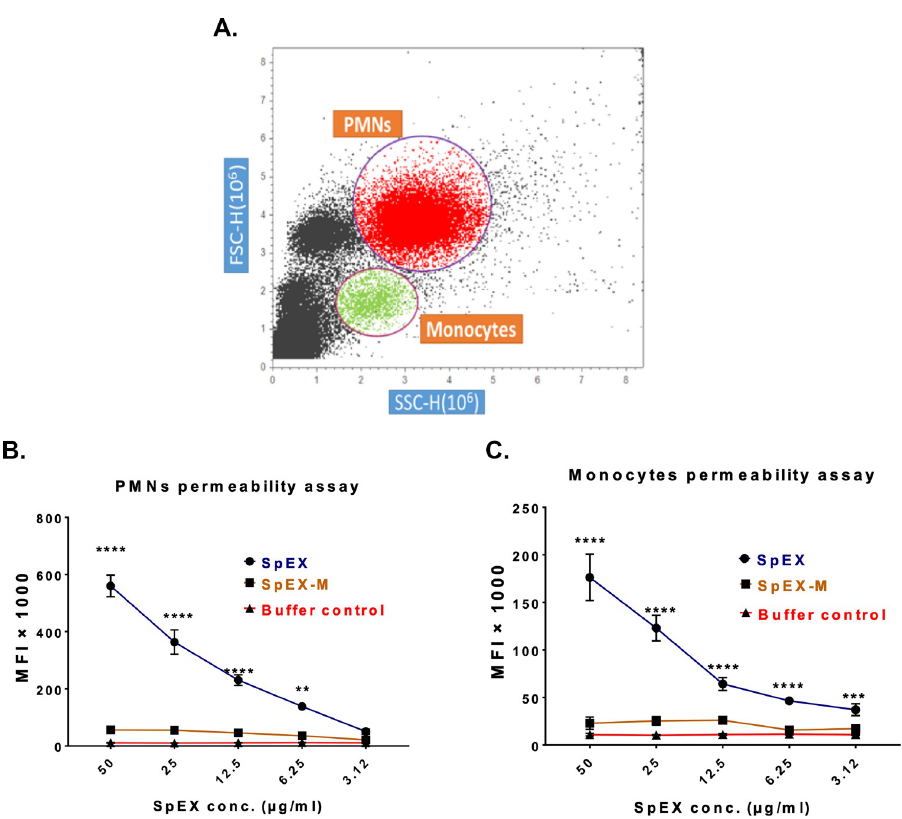
Fig 8. S . pseudintermedius recombinant SpEX has a cytotoxic effect on canine monocytes and PMNs. a . Gating on canine monocytes (green color) and PMNs (red color) was based on side and forward scatter (shown in dot plot). The mean fluorescent intensity (MFI) of the buffer control and SpEX-M relative to SpEX was significantly lower in PMN (P < 0.0001 ���� ) and monocyte (P < 0.0001 ���� ) permeability assays. The values were calculated based on average values from three independent experiments ( � P < 0.05 was considered significant, ���� P < 0.0001, ���� P = 0.0043).